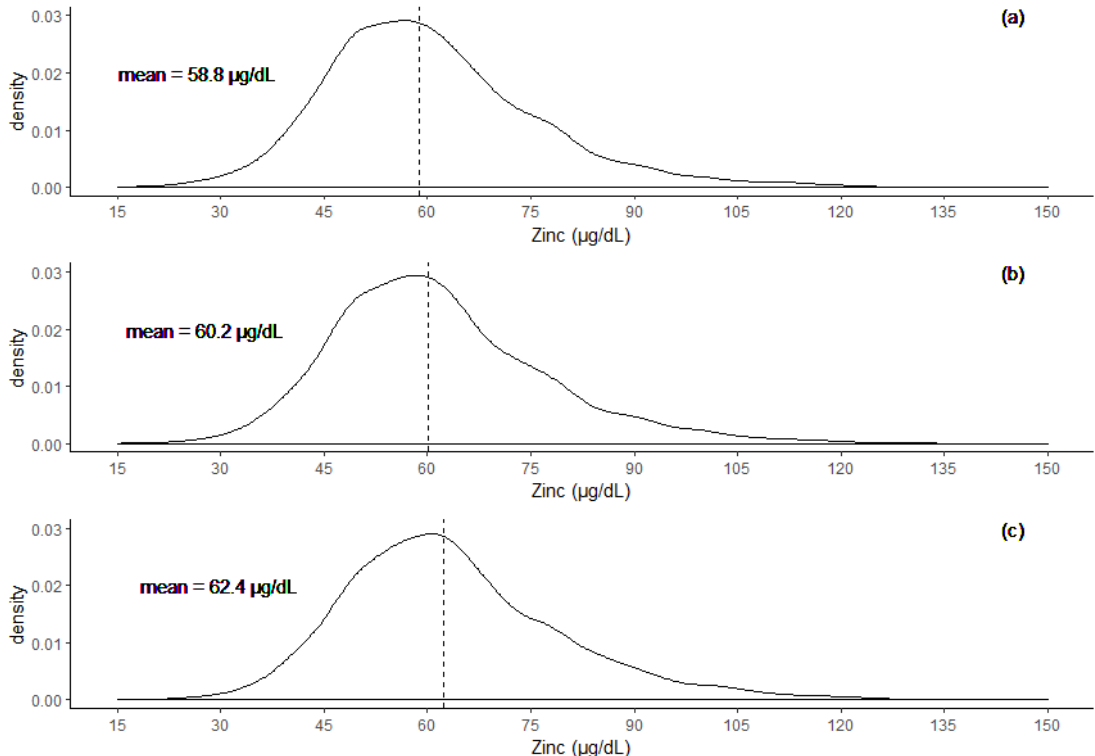
Figure 1. Density distribution of SZC values ( a ) before adjustment, ( b ) after adjusting with the ICF